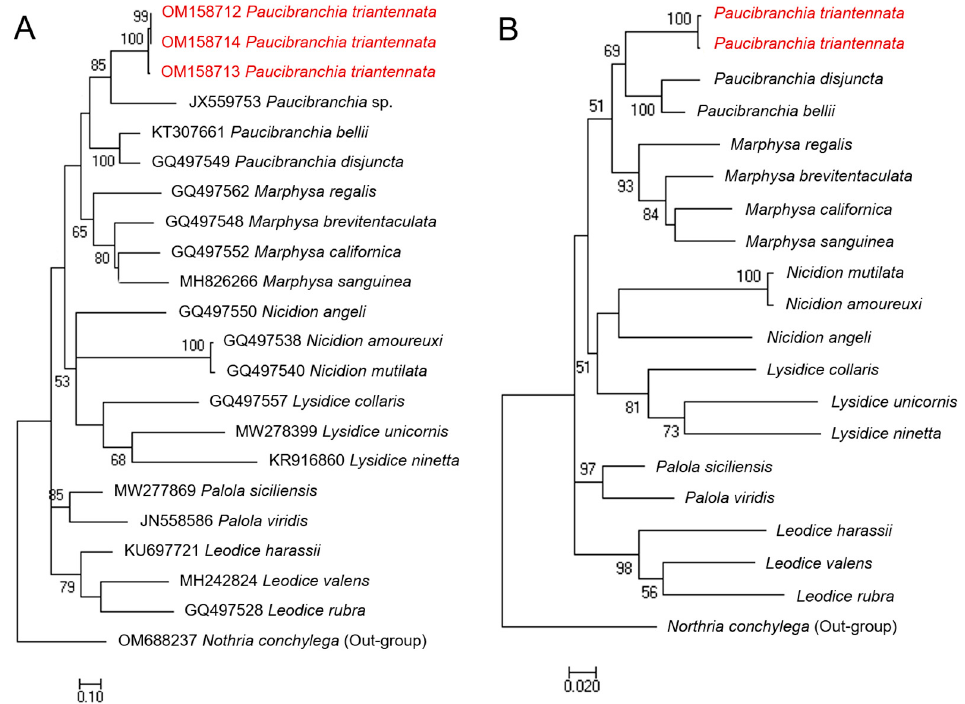
Figure 4. Molecular phylogenetic analysis conducted via the maximum likelihood method (General Time Reversible model): ( A ) phylogenetic tree using mtCOI, ( B ) phylogenetic tree using concatenated dataset of 18S rRNA and mtCOI. The alphanumerical identifiers in front of the species name indicate the GenBank accession number. The taxon Northria conchylega , a member of the family Onuphidae, is used as an out-group in these phylogenetic trees.